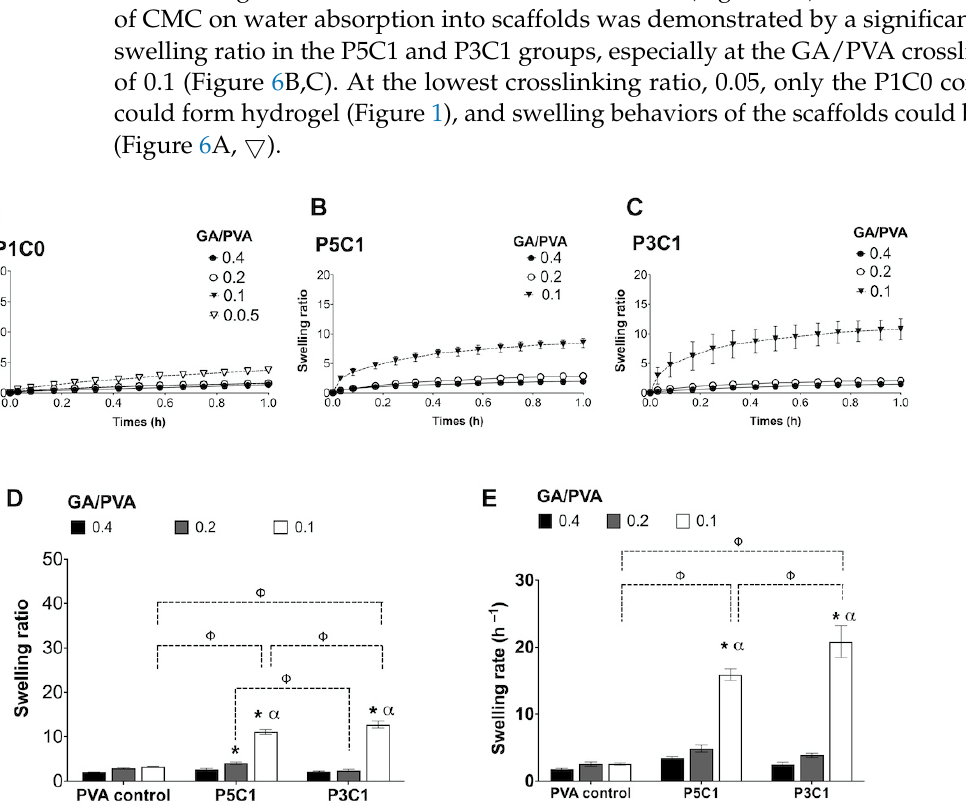
Figure 6. Swelling ratio. Swelling ratios of P1C0 ( A ), P5C1 ( B ) and P3C1 ( C ) were recorded for 1 h. The maximum swelling ratio at 24 h ( D ). Swelling rate of scaffolds was determined linearly over 30 min intervals ( E ). Data show average ± standard error; n = 4. φ indicates significant effects of CMC. * and α indicate significant effects of crosslinking compared with GA/PVA crosslinking ratios of 0.4 and 0.2, respectively.